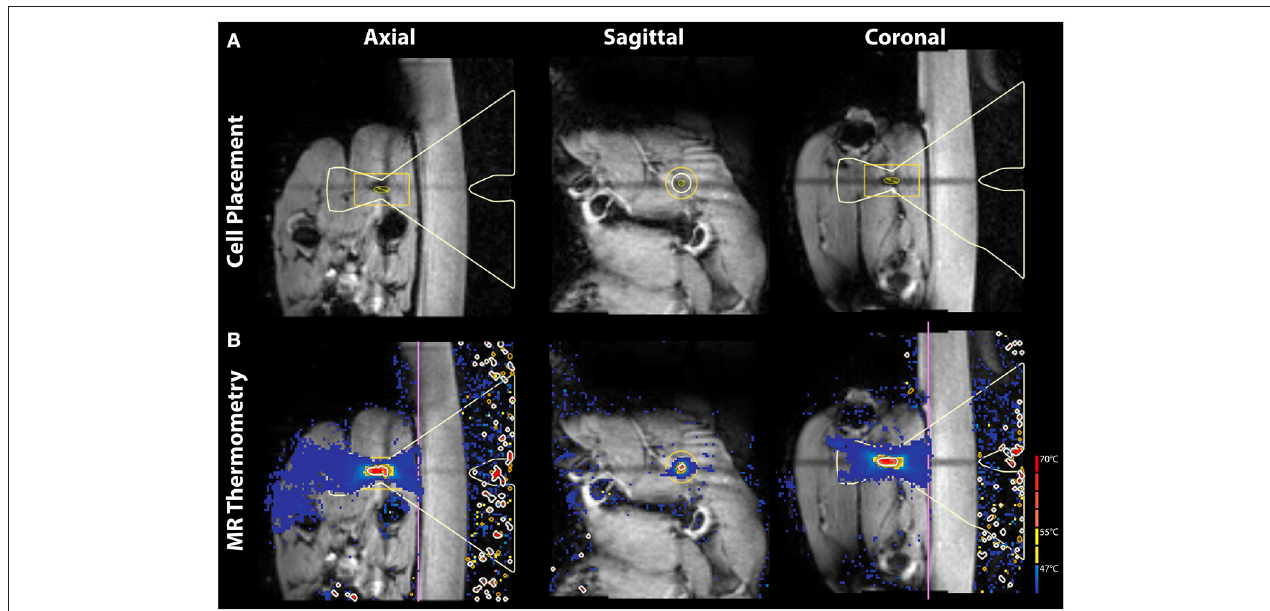
FIGURE 1 | Pre-treatment planning images and in-treatment MR thermometry in axial, sagittal, and coronal view. (A) T1-weighted images are shown with the MRgFUS treatment cell placed on the sciatic nerve. (B) In vivo MR thermometry displaying heat deposition during treatment.